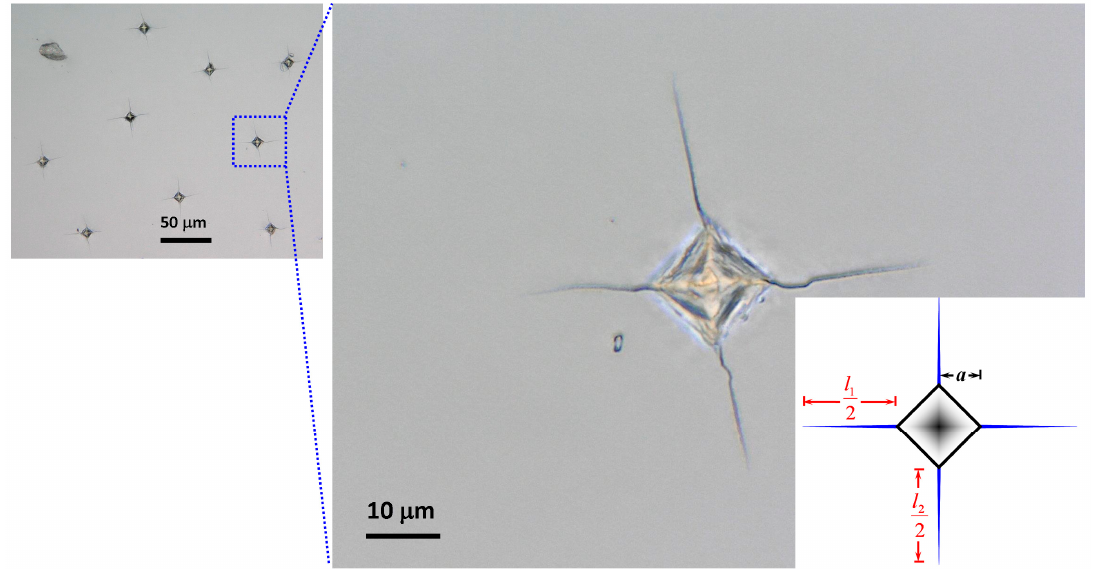
Figure 3. Palmqvist cracks obtained from Vickers indentation on GaP(100) single-crystal, where “ a ” is the half-diagonal of the indentation and “ l = ( l 1 + l 2 ) / 4” is the average length of the radial cracks for each indentation under a load of 1.96 N.